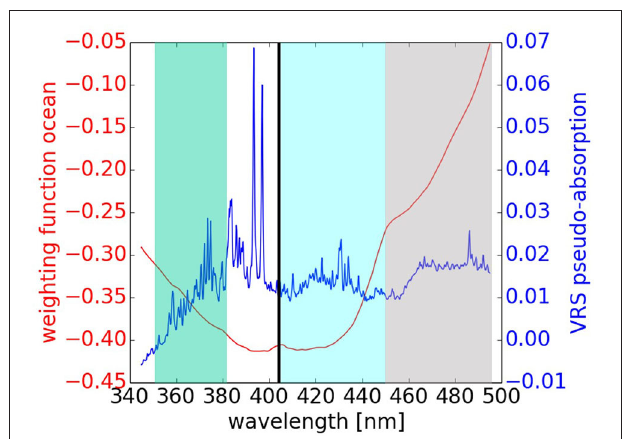
FIGURE 1 | Flow chart illustrating TROPOMI K d algorithm. FIGURE 2 | Simulated VRS pseudo-absorption and ocean weighting function